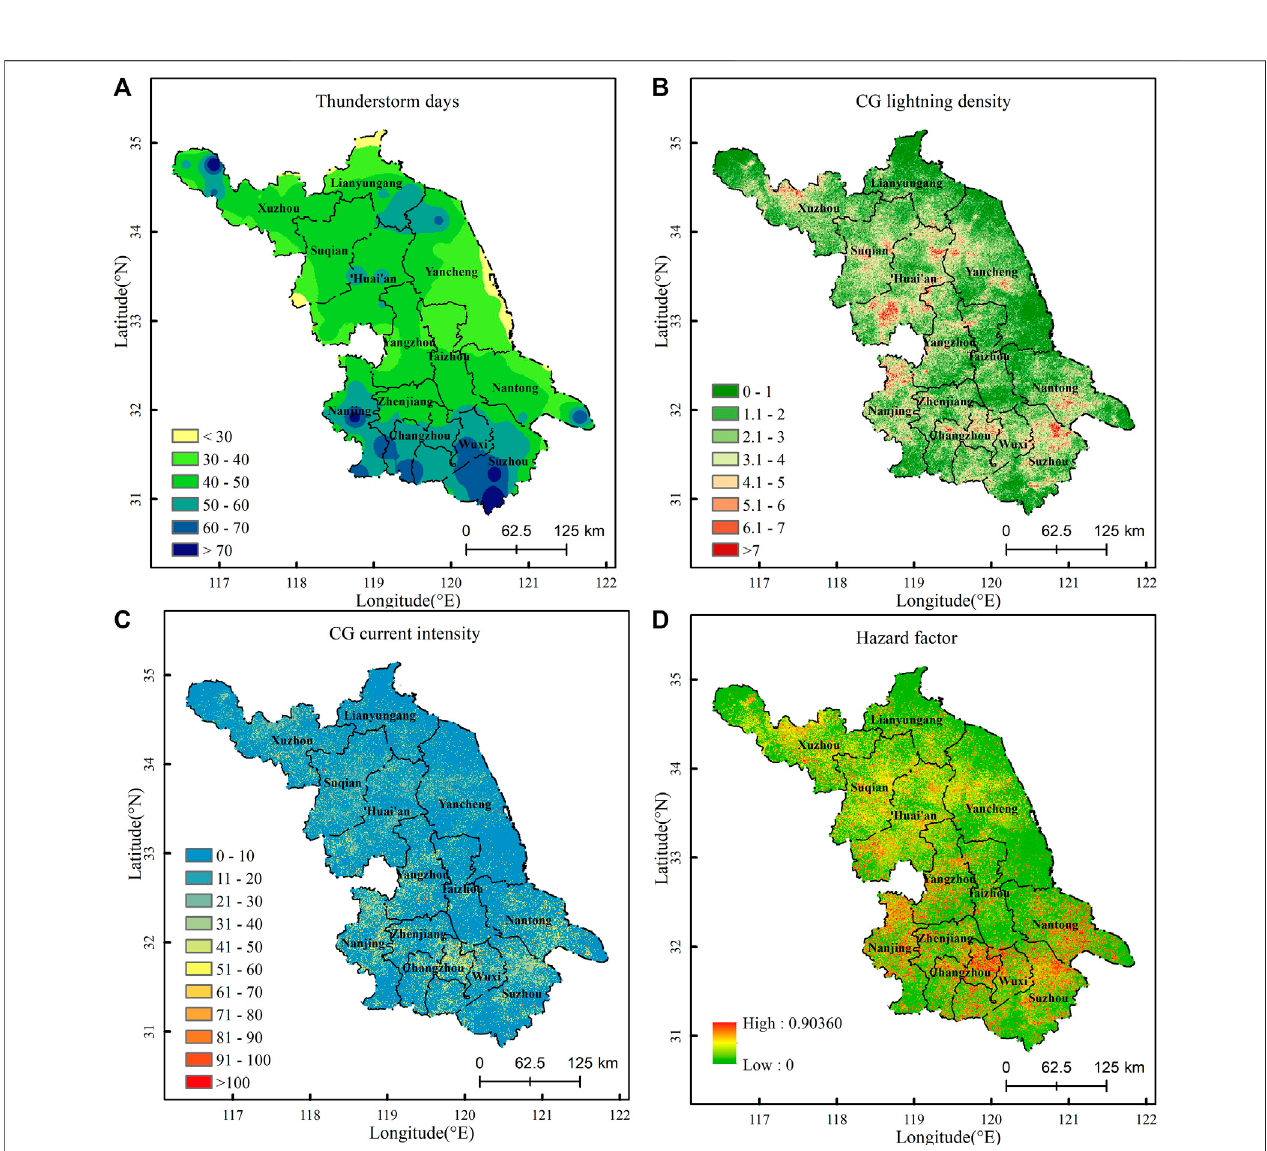
FIGURE 3 | Distribution of the risk of lightning hazard factors in Jiangsu. (A) Thunderstorm days, unit: days/year; (B) CG lightning density, unit: km 2 /year; (C) CG current intensity, unit: KA; (D) hazard factor.